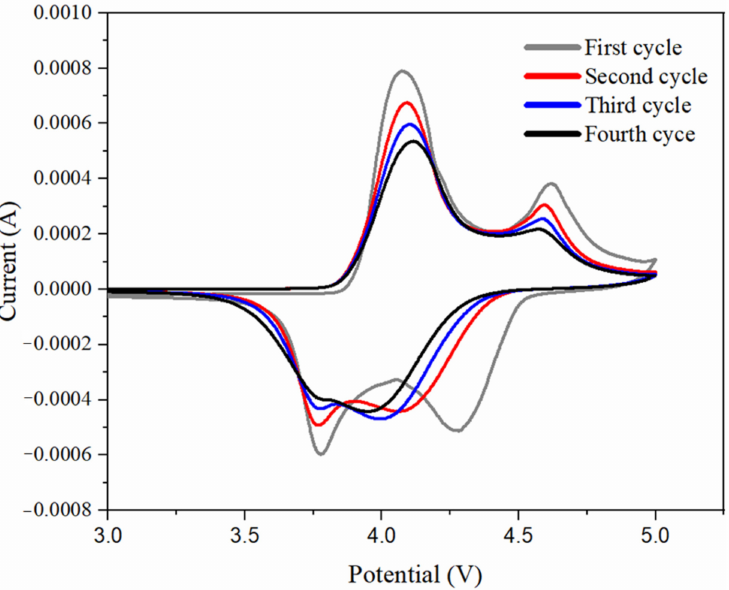
Figure 10. Cyclic voltammetry curve of Li 2 CoO 2 -Li half-cell assembled by P 1 D 5 O 5% P 10% membrane.